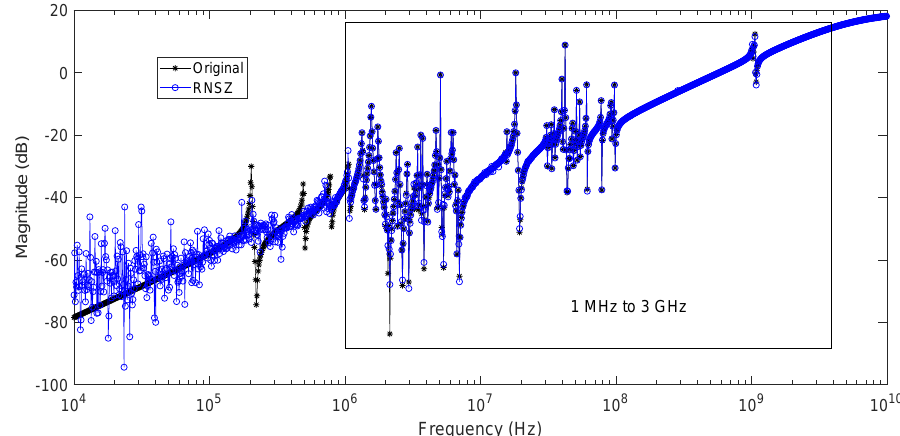
Figure 17. Original system frequency response of a spiral inductor (order n = 191) compared with a ROM generated using a high order (N = 180) RNSZ method covering 1 MHz to 3 GHz frequencies.